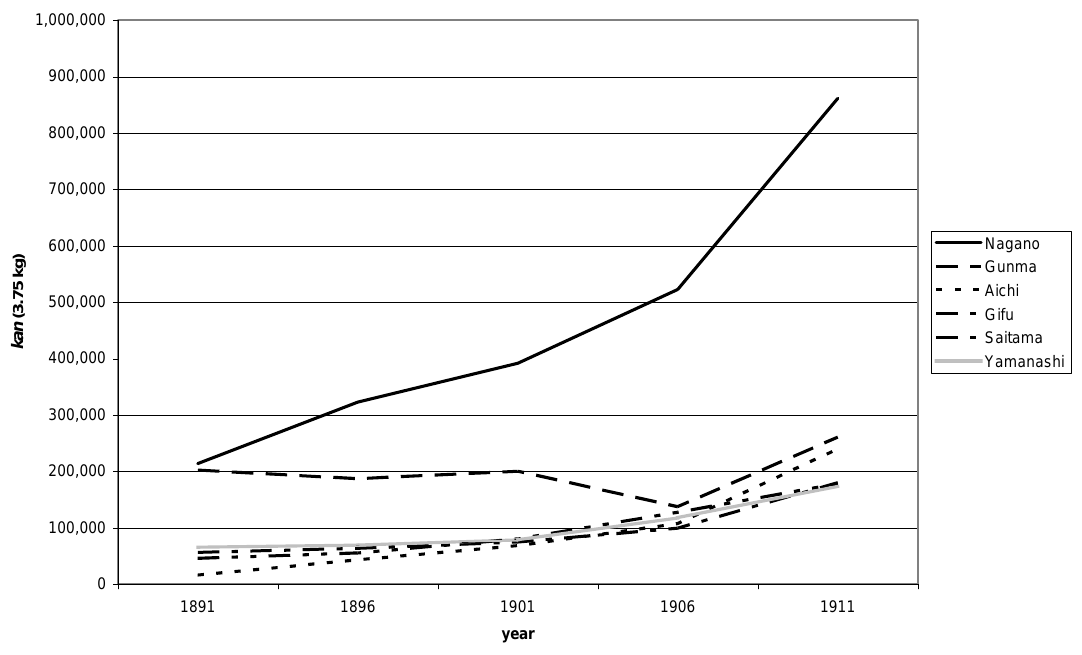
Figure 3. Raw Silk Production in Japan by Prefecture,